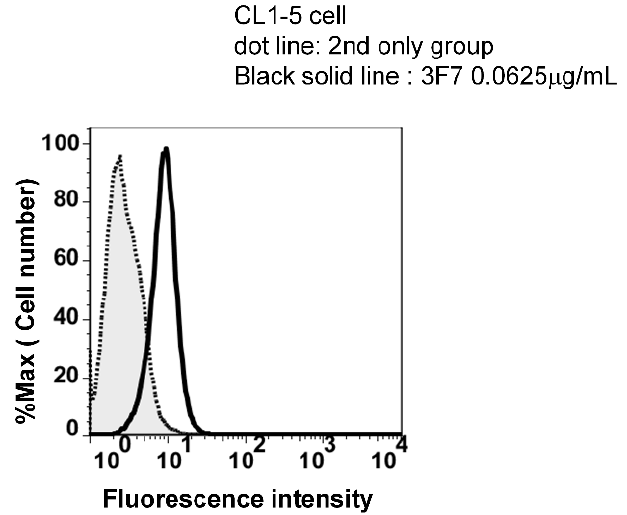
Figure A2. The layered structure and top view of the MVC chip.